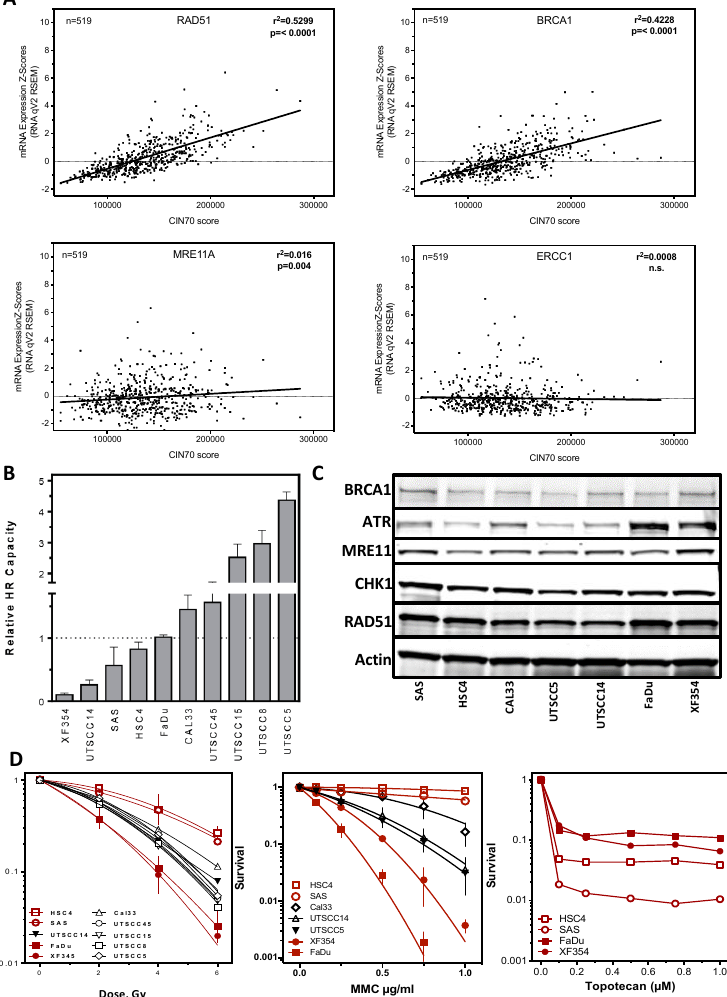
Figure 2. mRNA expression of HR proteins correlates with CIN70 score ( A ) The mRNA expression for the proteins RAD54B, BRCA1, MRE11, and ERCC1 was plotted against the corresponding CIN70 score of 519 HNSCC patients and calculated with linear regression. ( B ) Relative HR capacity in HNSCC cell lines (data taken from Wurster et al., 2016). ( C ) Protein expression of BRCA1, ATR, MRE11A, CHK1, and RAD51 of 7 unirradiated HNSCC cell lines. ( D ) Cellular survival after irradiation, mitomycin C and topotecan determined by the colony formation